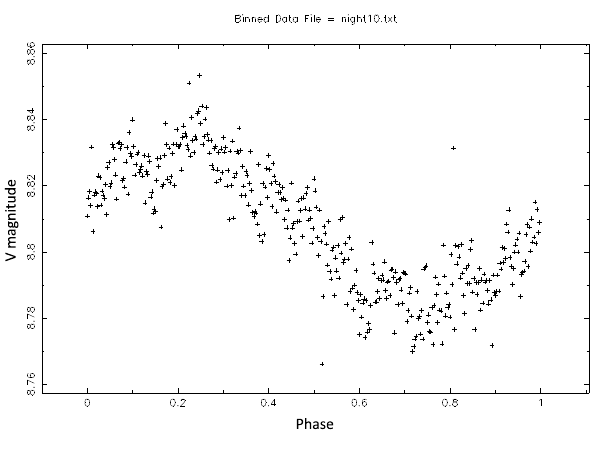
Figure 3: Night 3 outburst data folded on a period of 0.35273 days and binned into 400 bins. Note that the magnitude scale has brightness increasing